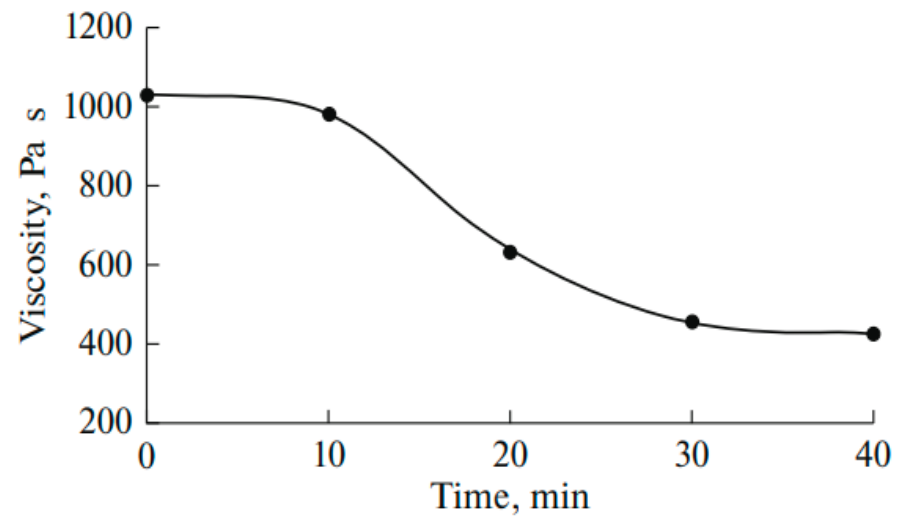
Figure 3. Changes in the viscosity of heavy crude from the Jinghe oilfield after ultrasound treatment [10].